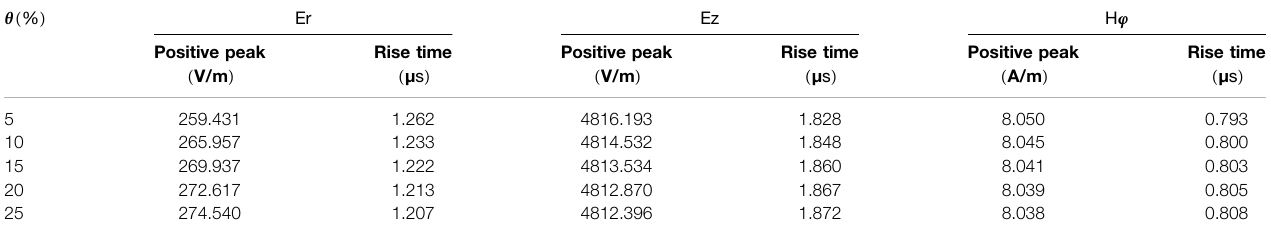
TABLE 2 | Peak values and rise times of the horizontal electric fi eld (Er), vertical electric fi eld (Ez), and azimuthal magnetic fi eld (H φ ) for different water contents θ when the porosity φ (cid:2) 40%; d (cid:2) 200m, h (cid:2) 10m. θ ( % )